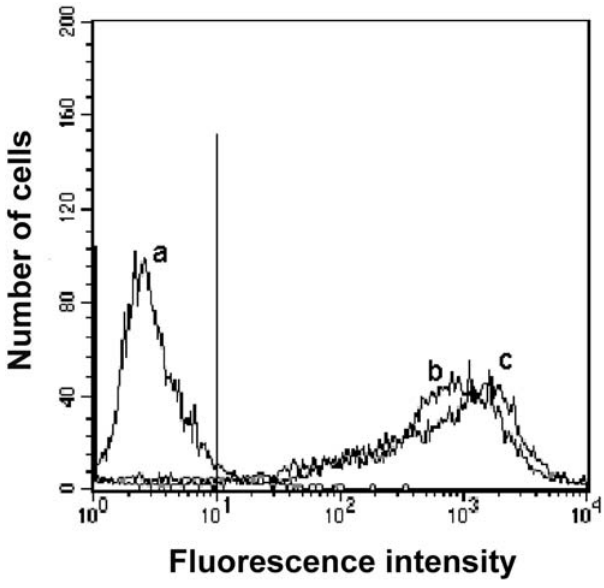
Figure 4. The binding of FITC-labeled TP5 onto the surface of EBV- transformed B cells. EBV-transformed B cells were incubated with PBS alone (trace a), FITC-labeled TP5 (trace b) and mAb-DR FITC (trace c), and then subjected to flow cytometry. The vertical line was the boundary between bound and unbound cells.